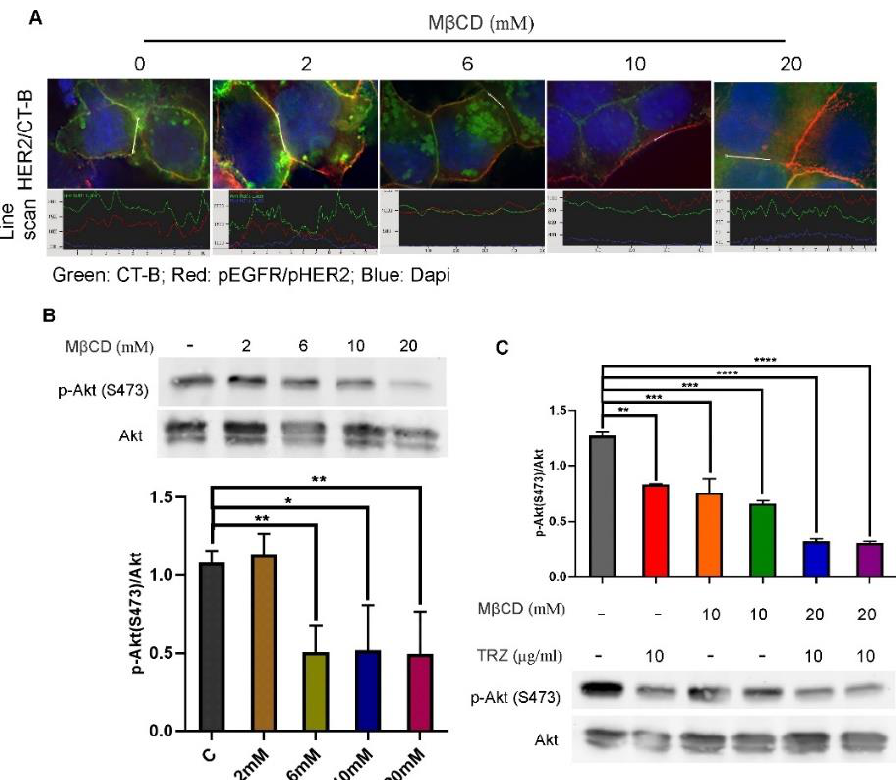
Figure 9. Disruption of lipid raft by M β CD and the effects on EGF-induced Akt phosphorylation. BT474 cells were treated with M β CD at various concentrations for 1 h to disrupt lipid raft. For the experiments with trastuzumab treatment, cells were incubated with trastuzumab and M β CD together for 1 h. Cells were then stimulated with EGF for 30 min. ( A ) CT-B stain (green) to show the disruption of lipid raft by M β CD. Cells were also stained with pHER2 (red). Line scan showed the intensities of CT-B and pHER2. ( B ) Dose-dependent effects of M β CD on Akt phosphorylation in BT474 breast cancer cells. Cells were treated with M β CD at indicated concentration for 4 h. The phosphorylation of Akt was then examined by immunoblotting. ( C ) Synergistic effects of trastuzumab and M β CD on Akt phosphorylation. Cells were treated with M β CD alone at 10 and 20 mM concentrations, or in combination with trastuzumab at 10 µ g/mL. The phosphorylation of Akt was then examined by immunoblotting. *: p < 0.05, **: p < 0.01, ***: p < 0.001, ****: p < 0.0001.